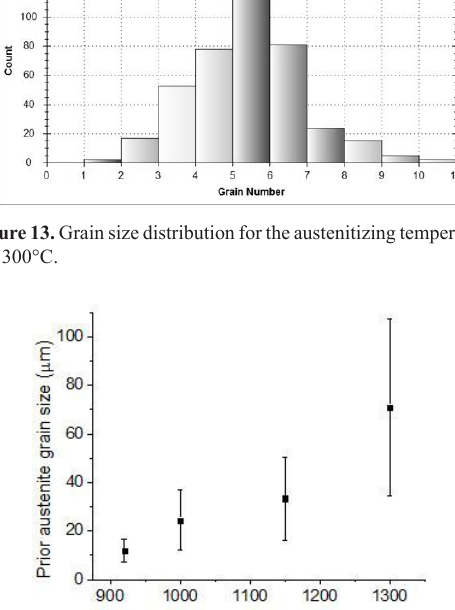
Figure 8. Prior austenitic grains for the austenitizing temperature of 1150°C. Etchant: Teepol. OM. 200x.